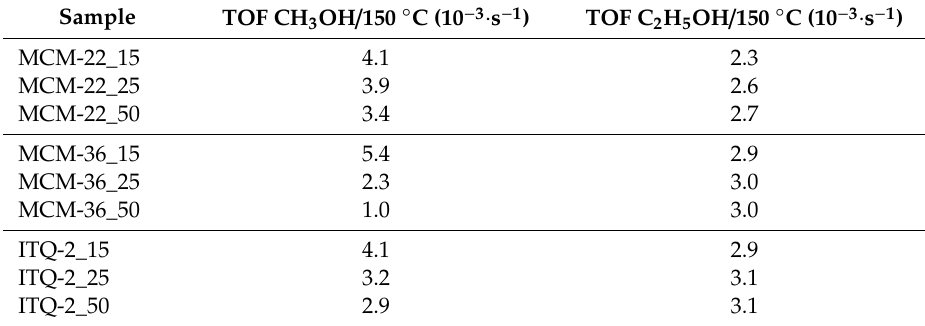
Table 3. Turn-over-frequency determined for methanol and ethanol dehydration over zeolitic samples at 150 ◦ C.